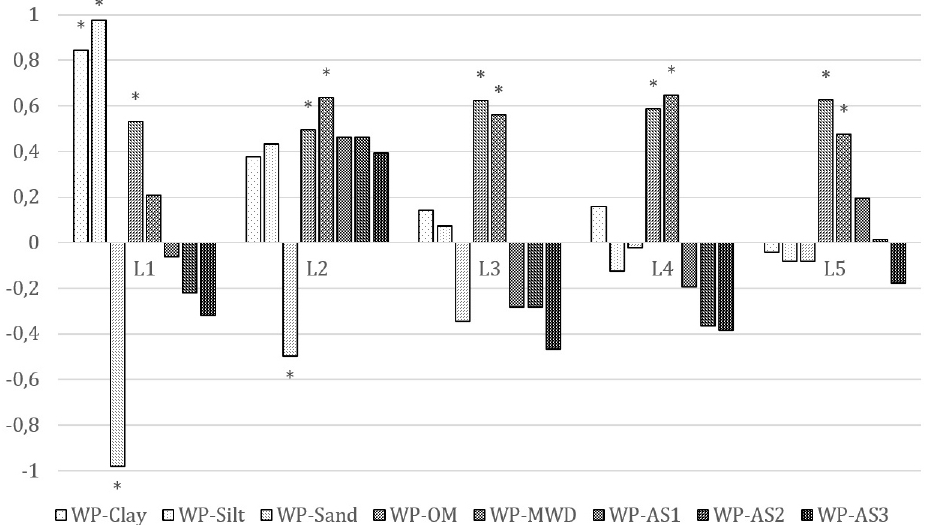
Figure 4. The correlation coefficients between wilting point and other properties in sampling areas (L1, L2, L3, L4 and L5 are the sampling sites; see Fig. 2). ∗ Significant relationship at α =